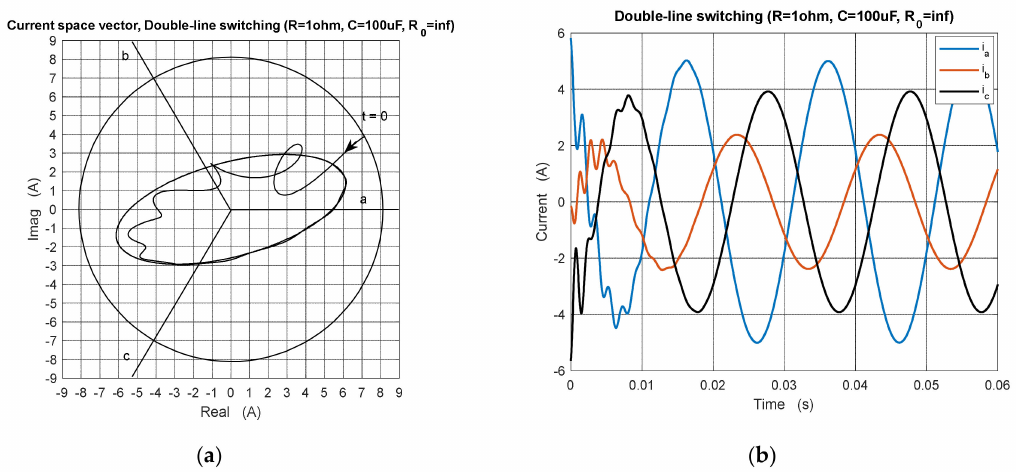
Figure 16. Double-line switching. Time-behavior of the current space vector ( a ) and the related phase currents ( b ) for the three-phase circuit in Figure 10 where S operates double-line switching of phases b and c with an impedance Z consisting of the series connection of a capacitor C = 100 µ F and a resistor R = 1 Ω . The single-phase circuit is open since R 0 → ∞ .